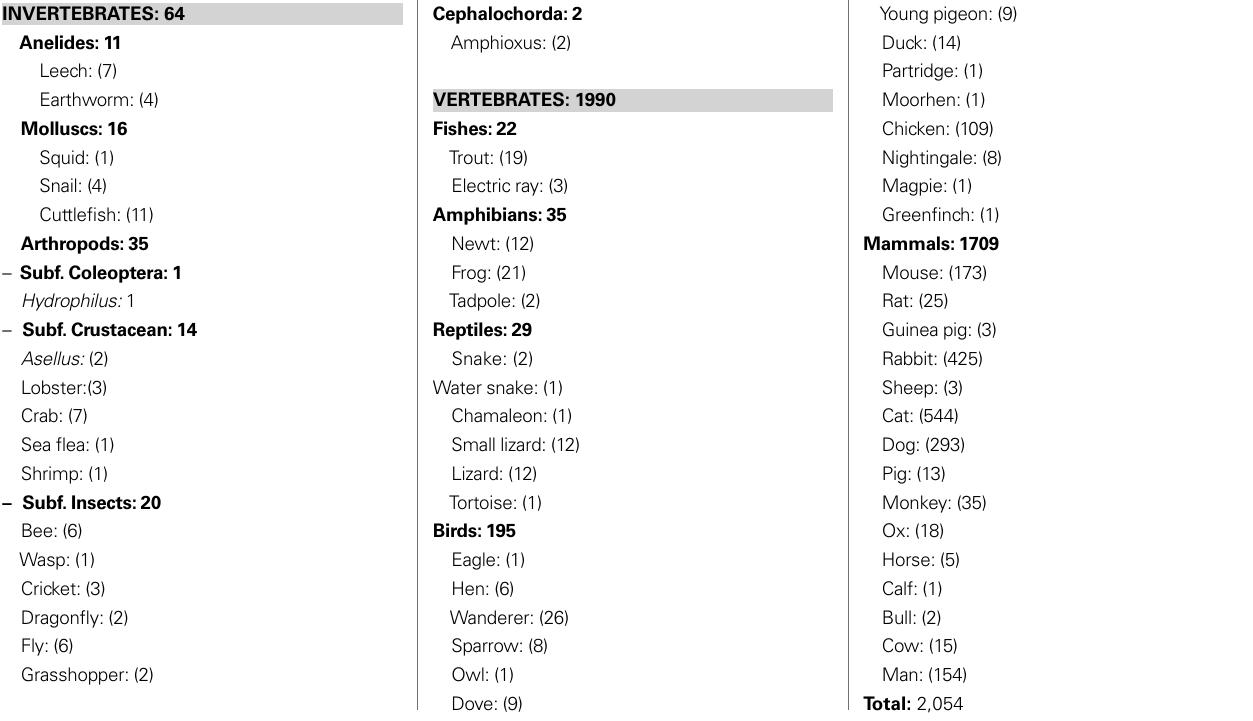
Table 3 | Animals used by S. Ramón y Cajal for making his histological